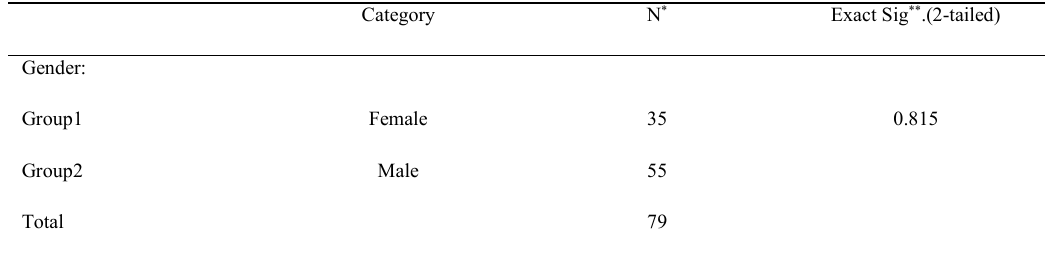
Table 5: Considering a binomial